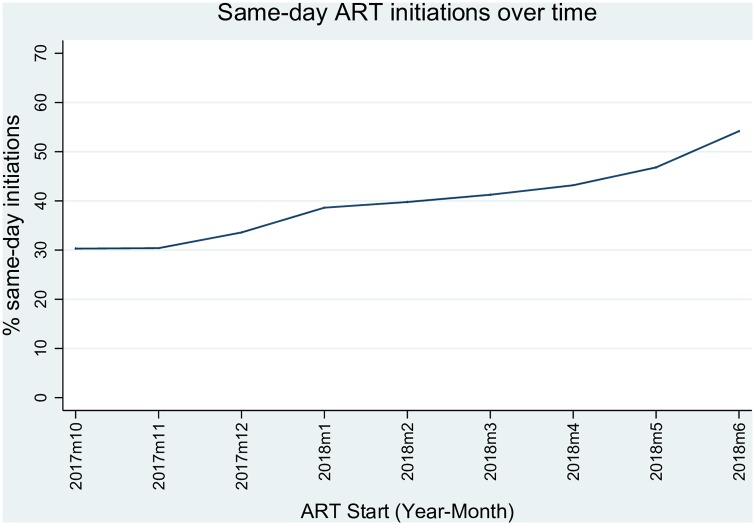
Trends in same-day antiretroviral therapy initiation over time.(ART, antiretroviral therapy).